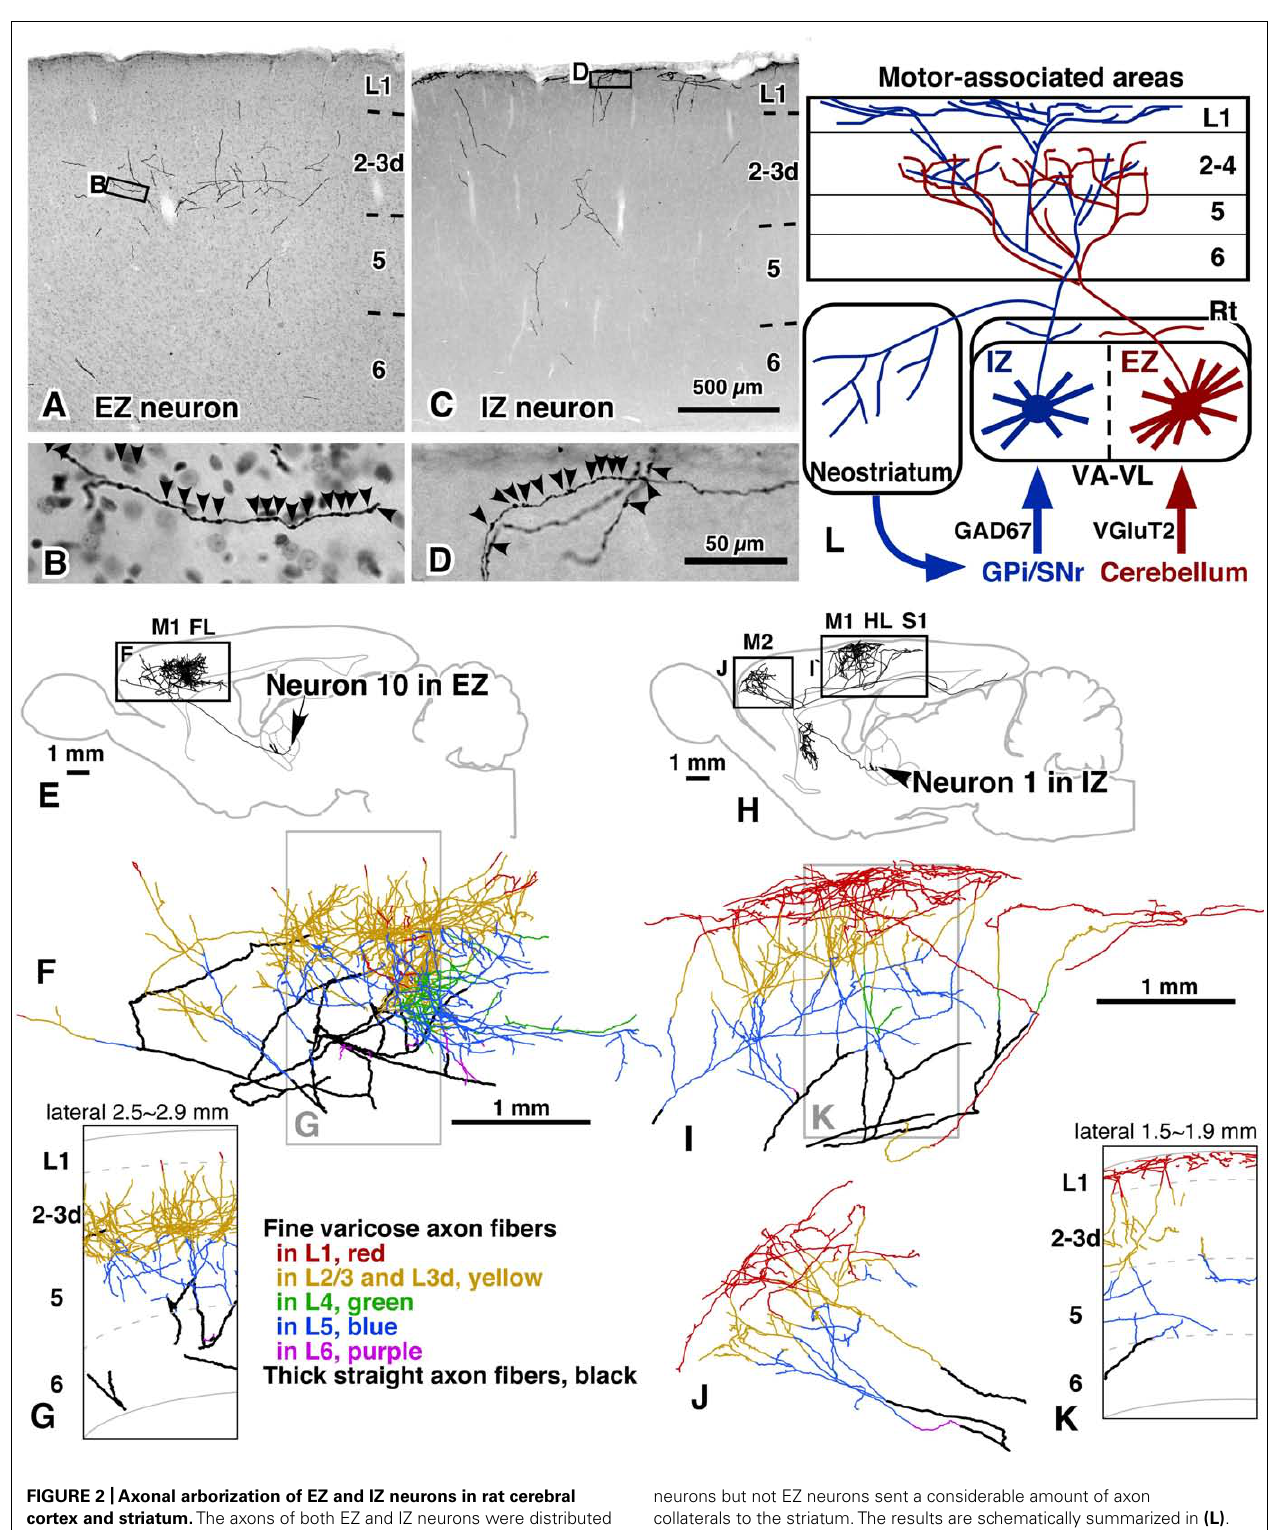
neurons but not EZ neurons sent a considerable amount of axon collaterals to the striatum.The results are schematically summarized in (L) . Modified with permission from Figures 5,6, and 9 of Kuramoto etal. (2009). Scale bar in (C) applies to (A,C) ; that in (D) to (B,D) ; and those in (F,I) to (F,G,I–K)